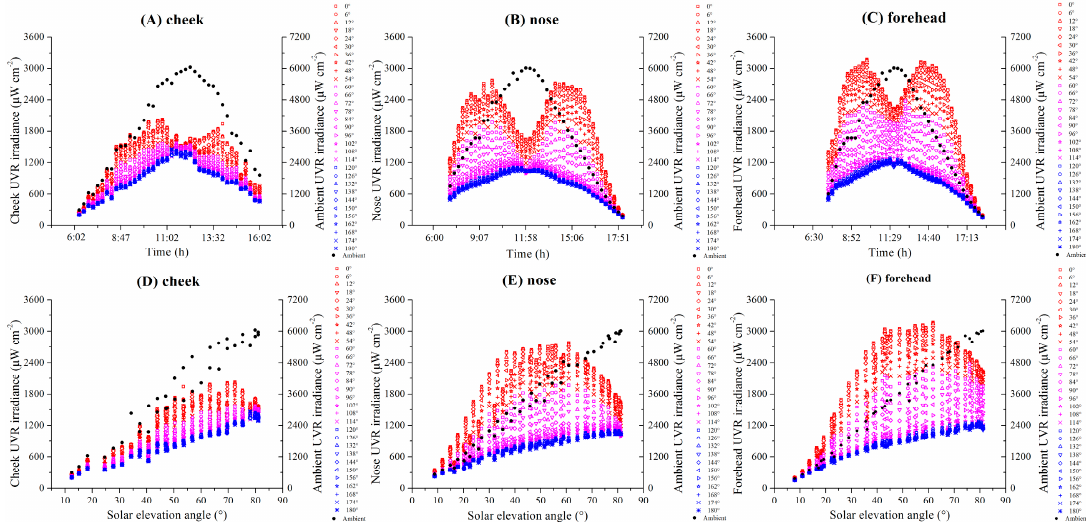
Figure 4. Diurnal variations of UV radiation (UVR) in different rotation angles and UVR changes with SEA. Notes: Since the distributions were approximately axisymmetric along the 0–180° direction, we reported the results from 0° to 180° rotation angles in intervals of 6°. ( A ), ( B ), and ( C ) show the diurnal variations of the UVR irradiance on the cheek, nose, and forehead in different rotation angles, respectively. ( D ), ( E ), and ( F ) show that the UVR irradiance on the cheek, nose, and forehead changes with SEA in different rotation angles, respectively.